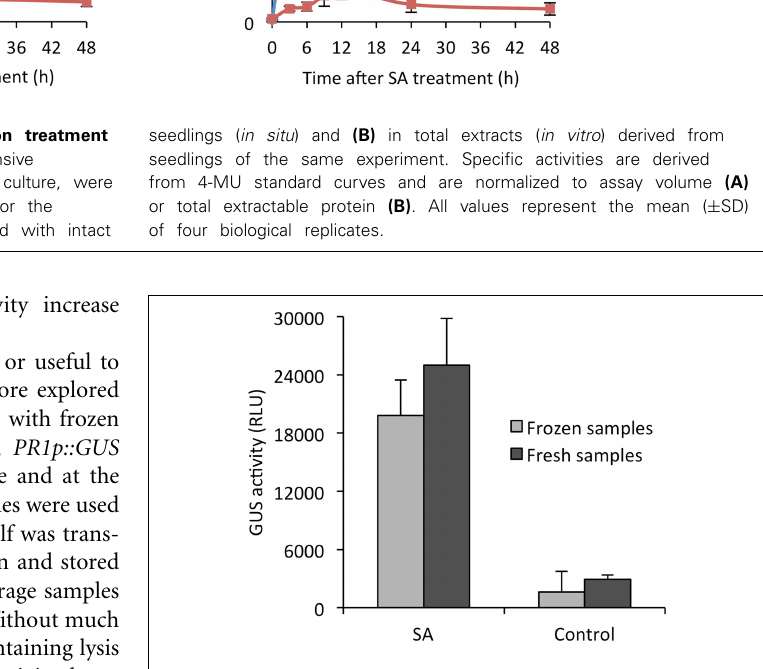
FIGURE 5 | Comparison of in situ GUS activity in fresh and frozen seedlings. Arabidopsis seedlings harboring the SA-responsive PR1p::GUS reporter gene, grown for 12 days in liquid culture, were treated with 200 μ M SA or 0.2% DMSO (control) for 24h. Half of the samples served for instant determination of GUS activity in situ (black bars) as described in Materials and Methods. The other half was frozen and stored at − 80 ◦ C for 4 weeks. For determining GUS activity, frozen seedlings were transferred to microplate wells prefilled with assay buffer containing 1mM 4-MUG and incubated for 90min before quantifying 4-MU fluorescence. Activity is given in relative light units (RLU) emitted from total assays and all values represent the mean ( ± SD) of four biological